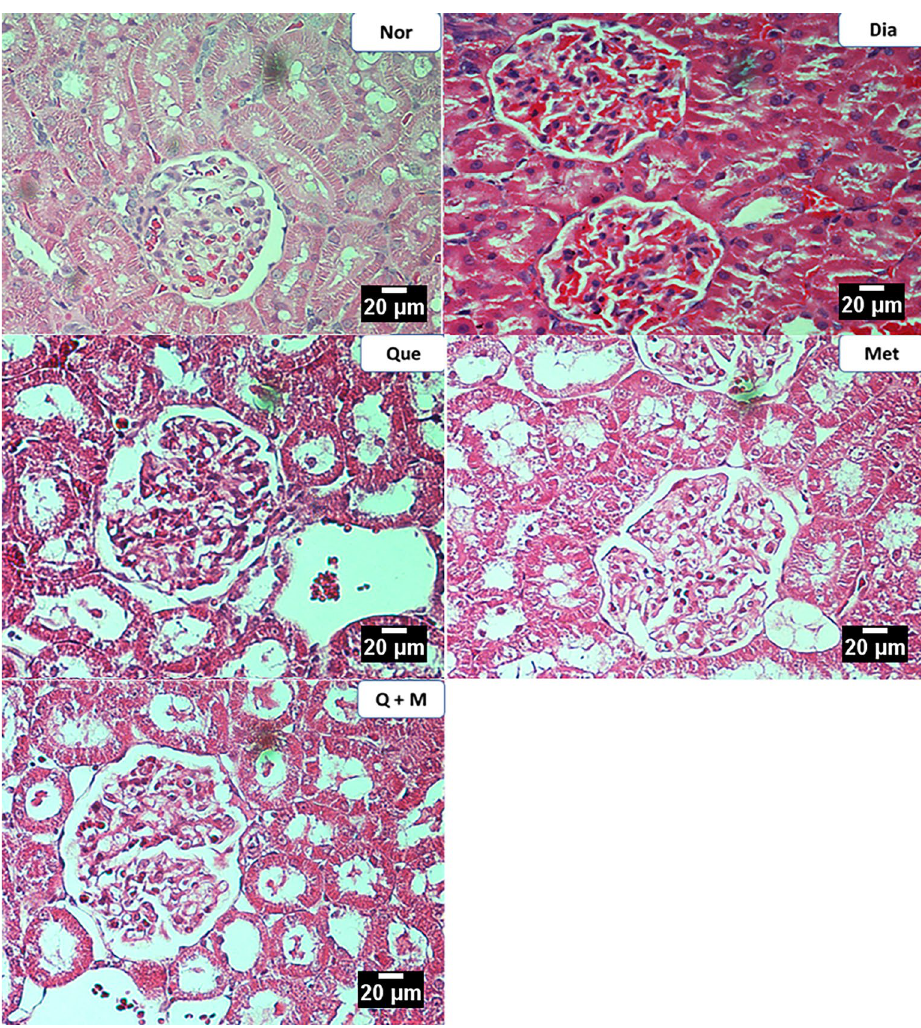
Figure 5. The effect of test compounds on kidney histology in diabetic rats. Nor Normal, Dia Diabetic, Que Quercetin treated, Met Metformin treated, Q + M Quercetin + metformin treated diabetic